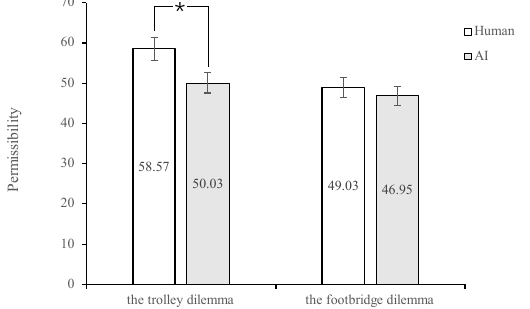
Figure 3. Rates of permissibility on human and AI agents. Note. * p < 0.05. Wrongness. A 2 (Dilemma Type: trolley dilemma vs. footbridge dilemma) × 2 (Agent Type: human vs. AI) × 2 (Action: action vs. inaction) analysis of variance, using wrongness